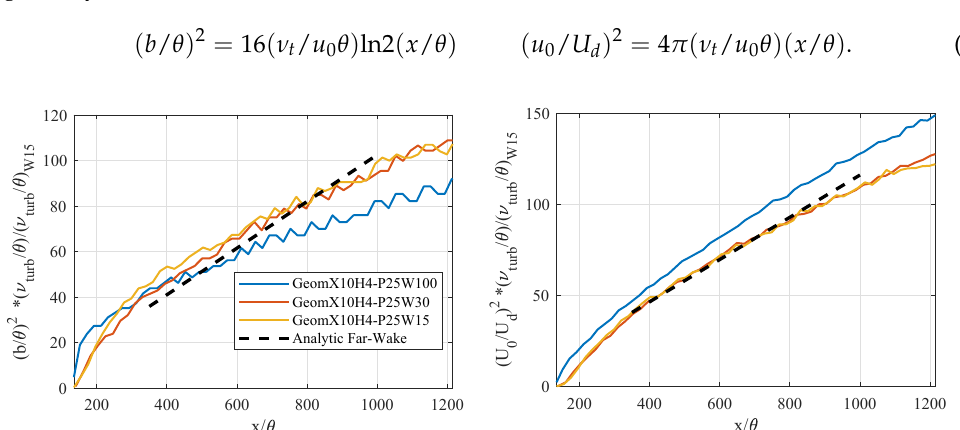
Figure 8. Asymptotic evolution of the wake’s parameters, for the three mesh refinements in the wake region, and comparison with the corresponding analytical